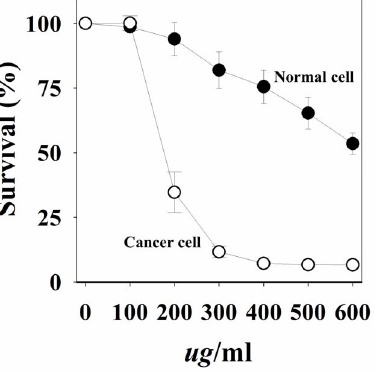
Figure 9. Comparison of cell proliferation between normal and cancer cells. The average values for 3 independent experiments are shown.